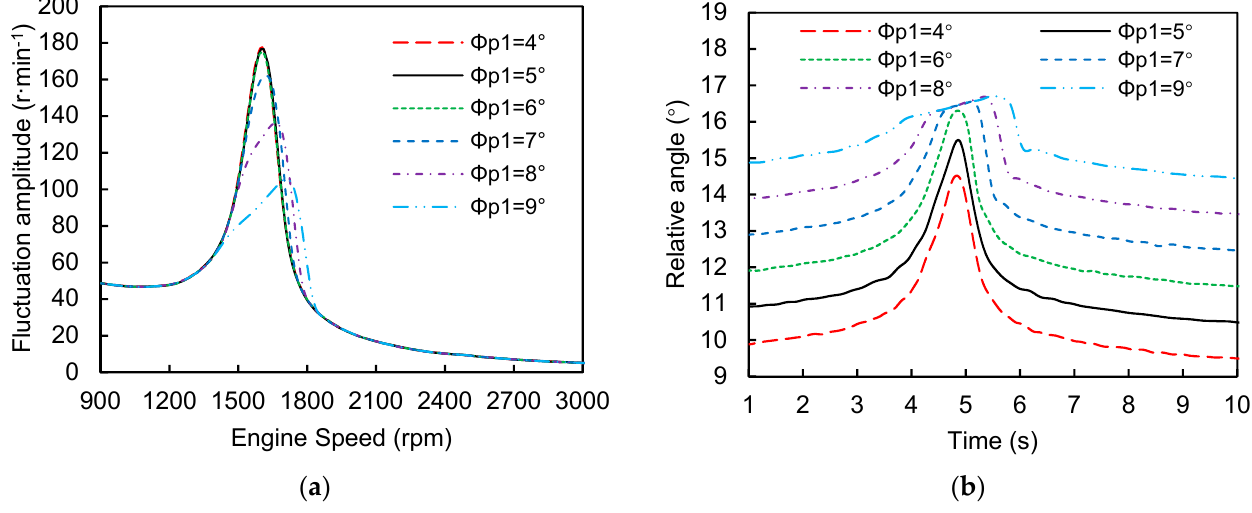
Figure 10. Influence of the second end − stop angle Φ p 2 on the torsional vibration of driveline. ( a ) Second − order speed fluctuation of transmission; ( b ) upper envelope of the relative angle of the clutch (baseline: the black solid curve).